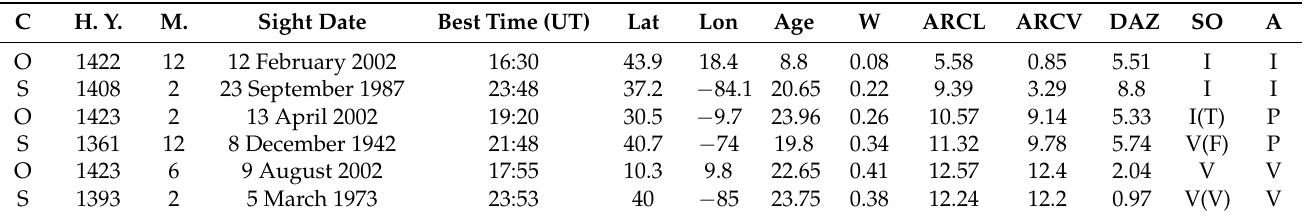
( d ) Figure 4. Results of the pattern recognizer ANN training: ( a ) Best training performance with a MSE of 0.1134; ( b ) Error histogram of the dataset entries; ( c ) Confusion table of ANN output rela- tive to the desired target; ( d ) Receiver Operating Characteristic of the ANN.